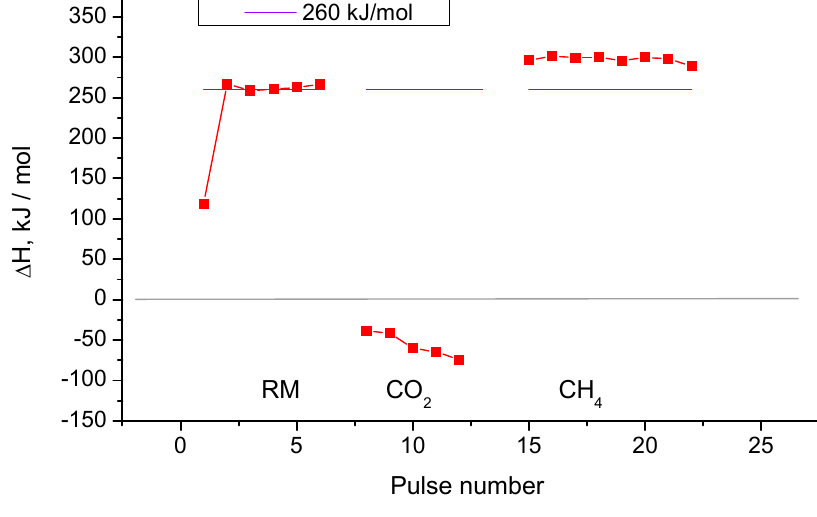
Figure 9. Measured heat effects during pulses of different compositions at 773 K.